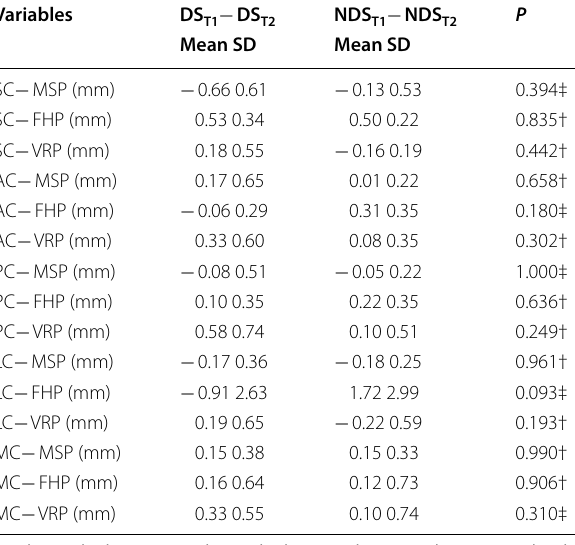
DS, deviated side; NDS, non-deviated side; †paired t test; ‡Wilcoxon signed rank test